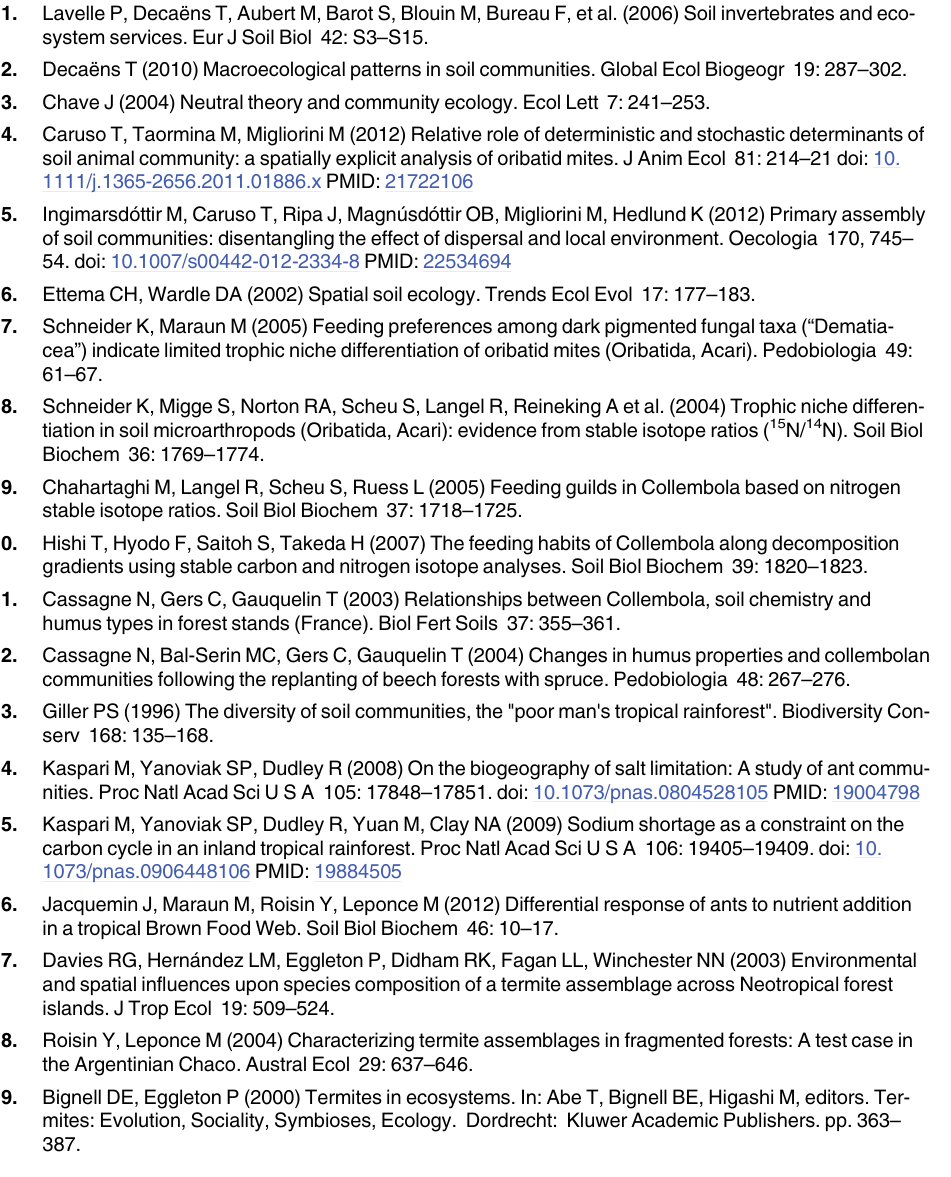
S1 Table. Raw data for the 148 samples analysed in this